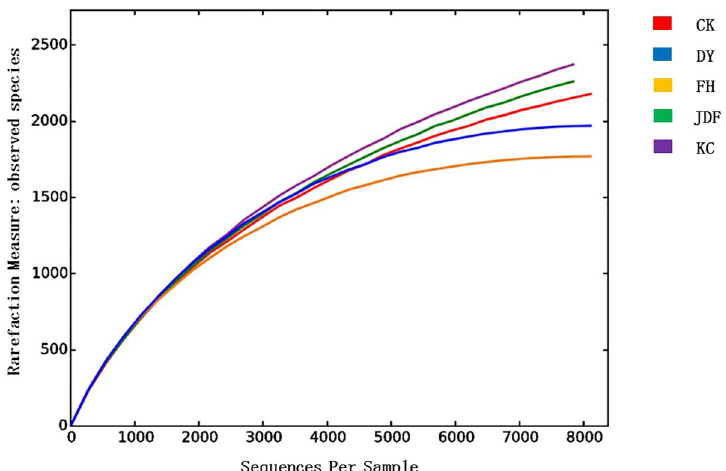
Fig 1. Rarefaction curves based on the observed species in the bacterial communities in maize rhizosphere soil. The abscissa represents the randomly selected sequencing data. The ordinate represents the number of observed operational taxonomical units (OTUs). When the curve tended to be flat, the amount of sequencing data was reasonable. CK, KC, DY, JDF, and FH groups indicate control, B . subtilis , B . licheniformis , B . amyloliquefacien s, and combined strains treatments, respectively.